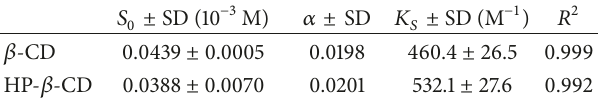
Figure 2: Phase solubility diagrams of terbuthylazine with ( ◼ , — blue) 𝛽 -CD and ( 󳵳 , — red) HP- 𝛽 -CD, in aqueous solution at 25 ± 2 ∘ C. Values are mean ± SD (𝑛 = 3) . Table 1: Stability constants ( 𝐾 𝑆 ) of terbuthylazine inclusion com- plexes with the studied